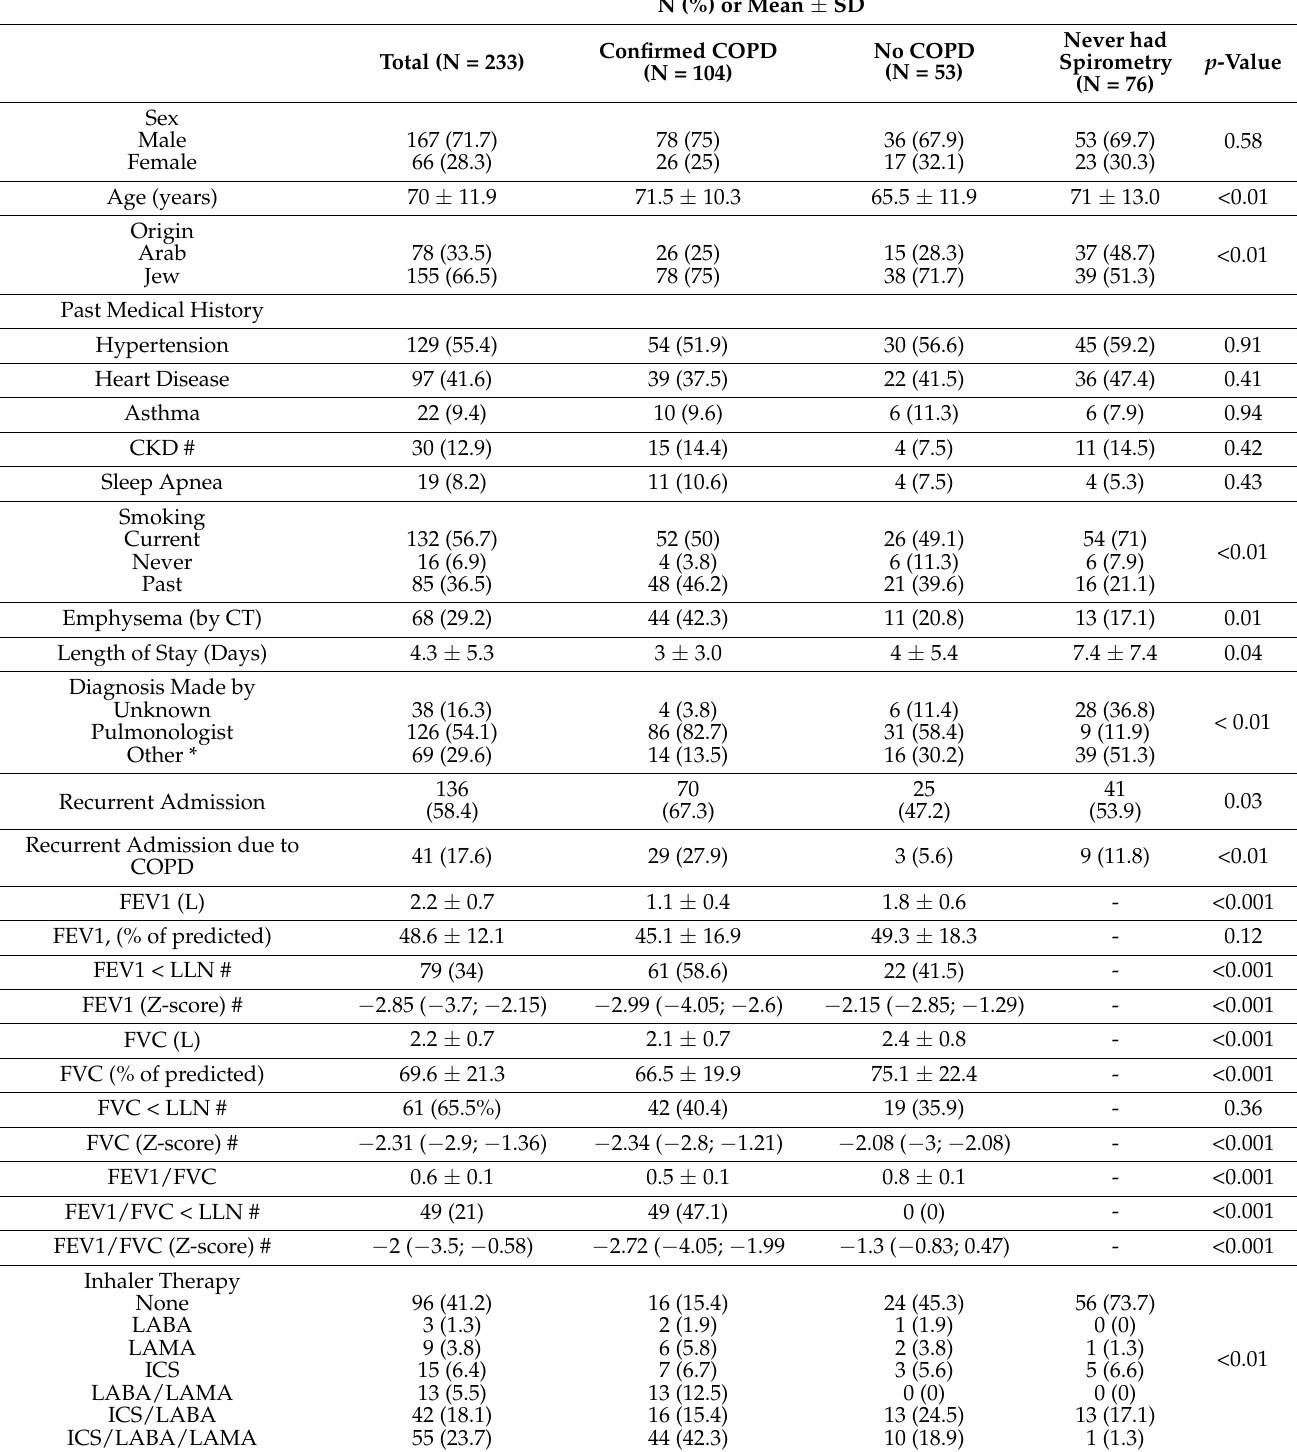
Table 1. Comparison between the patient